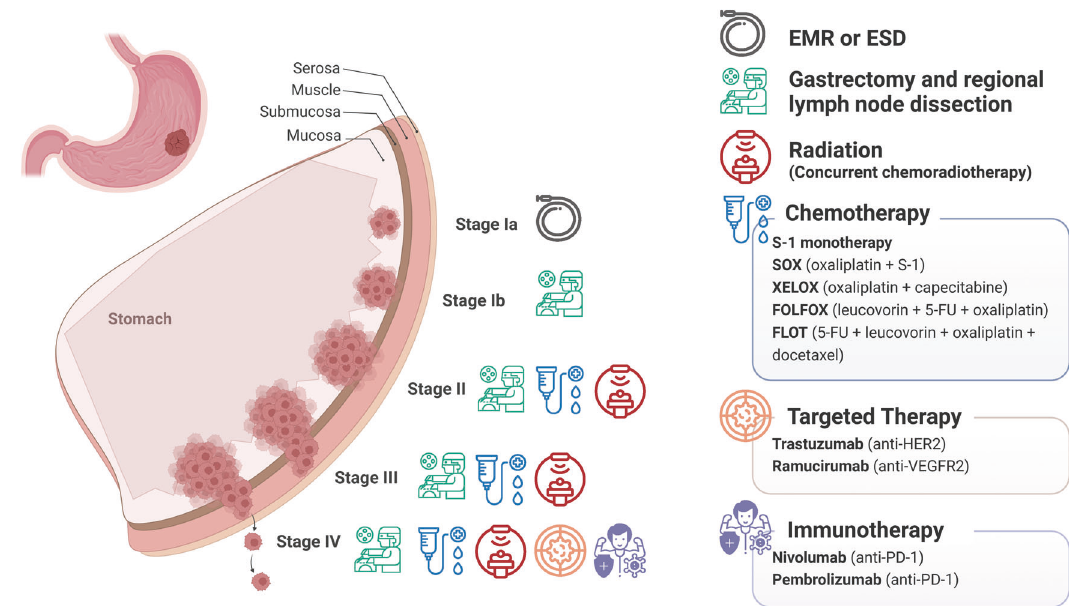
Fig. 4 Current therapies for gastric cancer based on staging. Therapeutic interventions for GC at different stages are illustrated by icons. The majorly used drugs or regimens of chemotherapy, targeted therapy, and immunotherapy are listed. EMR endoscopic mucosal resection, ESD endoscopic submucosal dissection. S-1 is an oral agent that is converted to 5-FU in the body, which contains a 5-FU prodrug called tegafur and the two enzyme inhibitors 5-chloro-2,4-dihydroxypyridine (CDHP) and oteracil potassium (Oxo), in a molar ratio of 1:0.4:1. This fi gure was adapted and modi fi ed from “ Gastric Cancer Staging ” by Biorender.com (2022). Retrieved from https://app.biorender.com/biorender-templates. Icons were adapted from Adobe